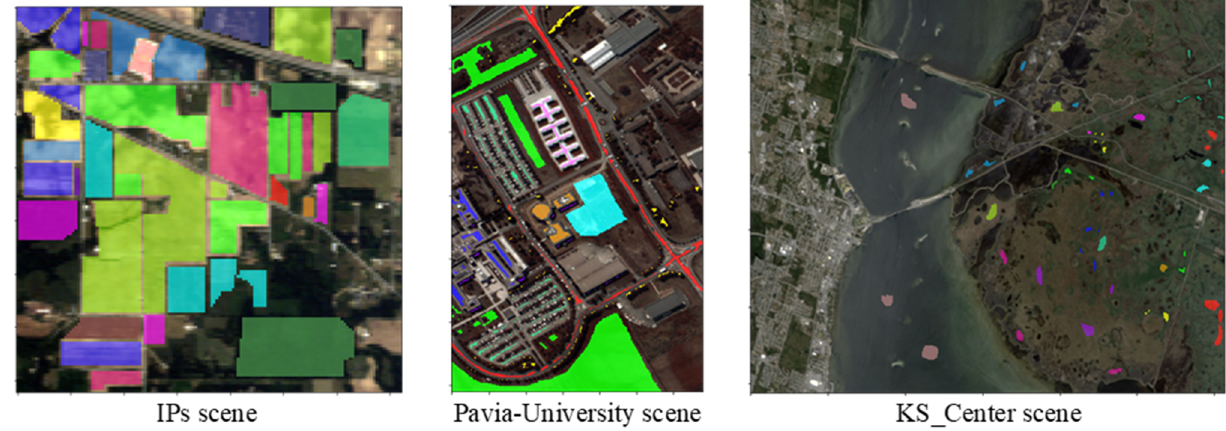
Figure 2. Dataset images with the ground truth.